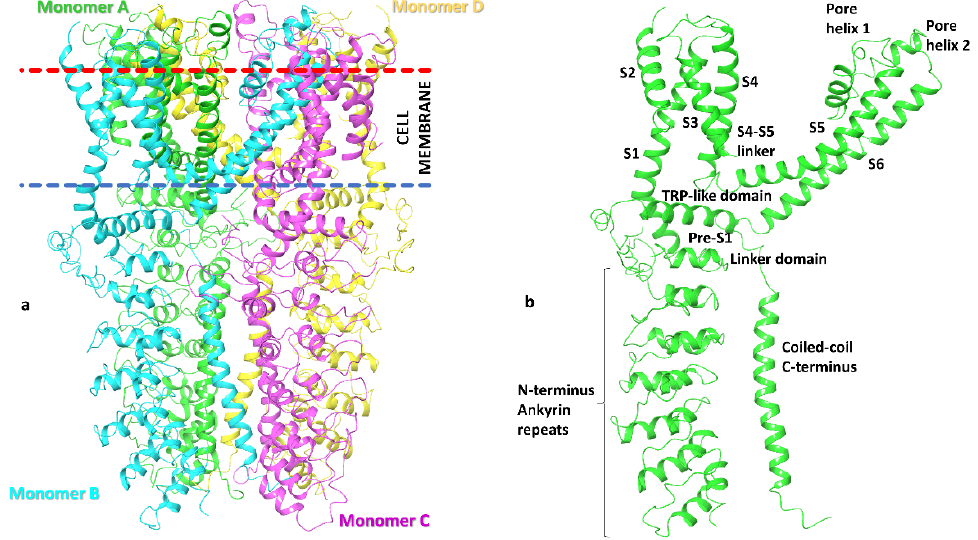
Figure 1. TRPA1 structural analysis: ( a ) distribution of the four homomonomers that form the TRPA1 ion channel and its arrangement in the cell membrane (based on information in OPM database); ( b ) structural details of a single TRPA1 subunit.